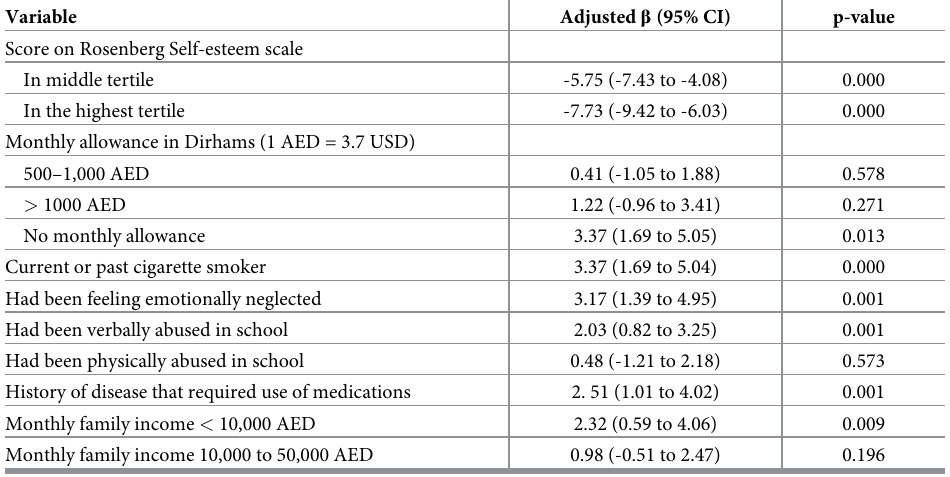
Table 4. Predictors of depressive symptoms among adolescents aged 12–18 years (n = 518) in Al Ain UAE �